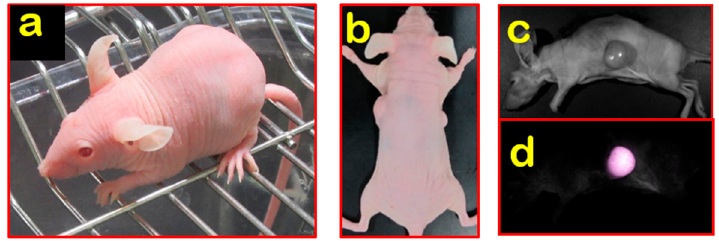
Figure 2. Nude R / J mice: ( a ) BALB / c Nude Rag-2 / Jak3 double-deficient (Nude R / J) hairless phenotype; ( b ) direct visualization of subcutaneous tumor nodules in Nude R / J; ( c – d ) fluorescent signals observed in Nude R /